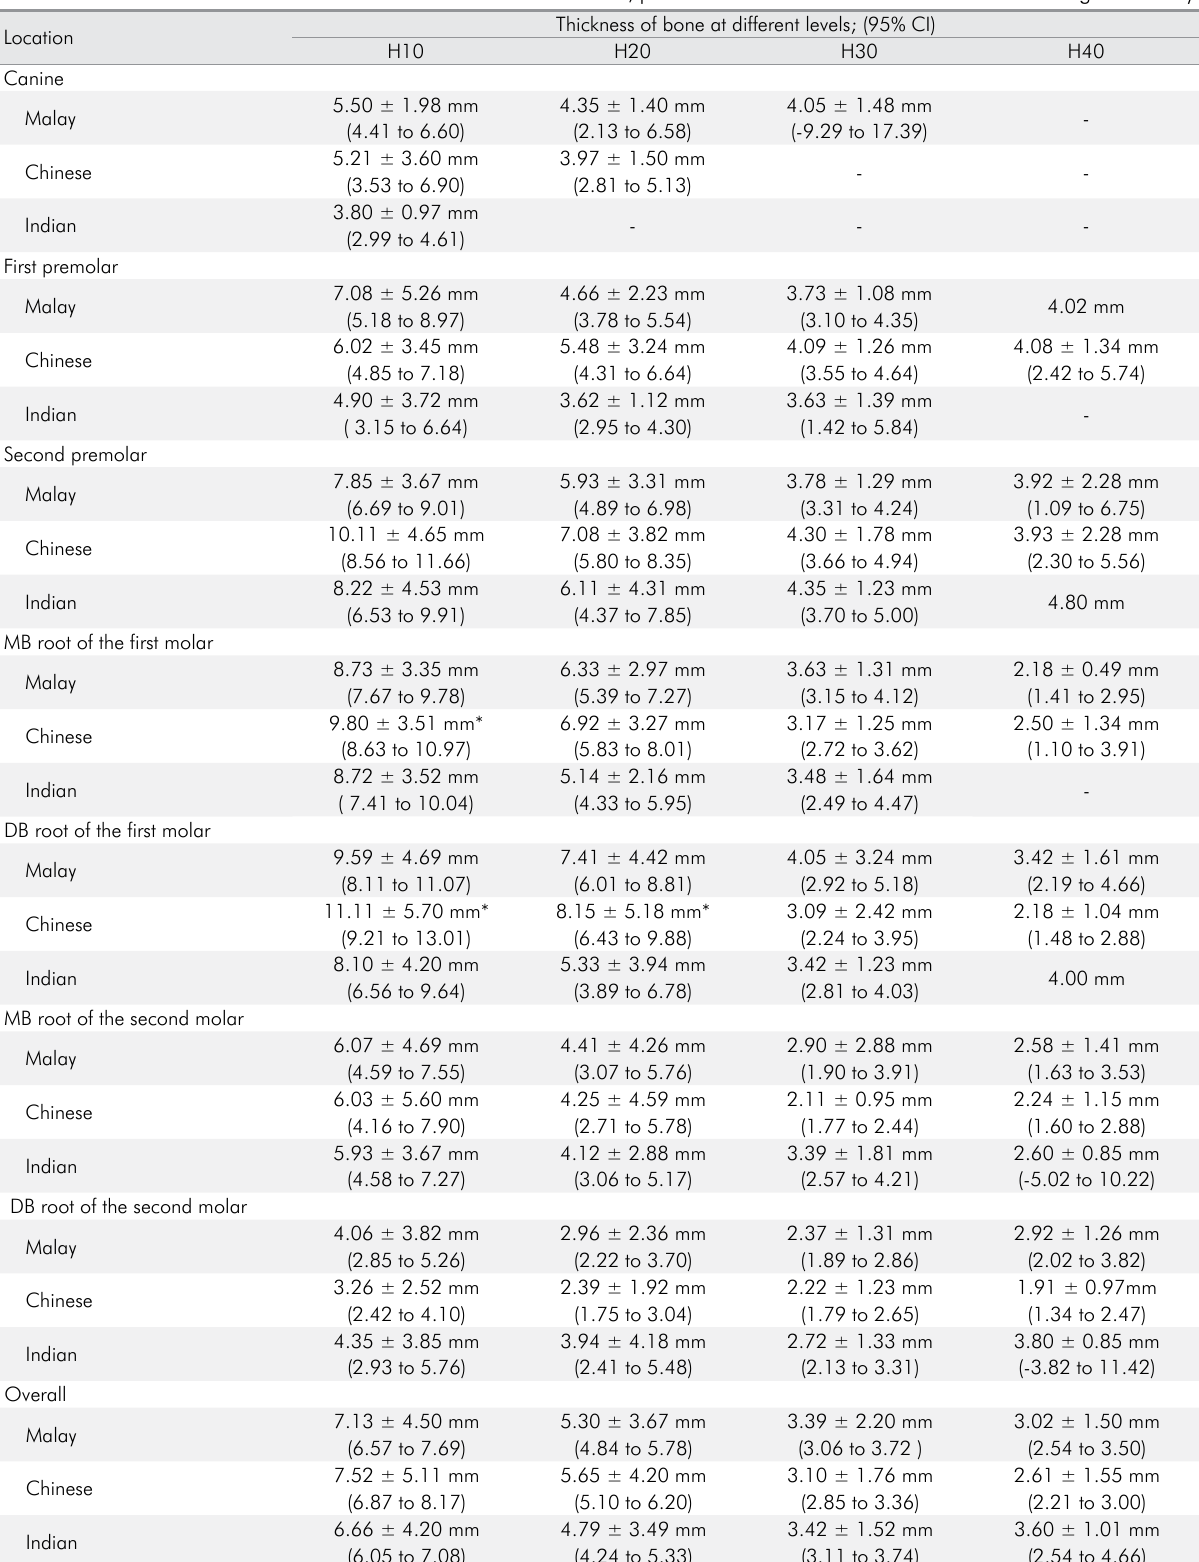
Table 2. Thickness of bone at different levels in relation to the canine, premolars and first and second molars according to ethnicity.